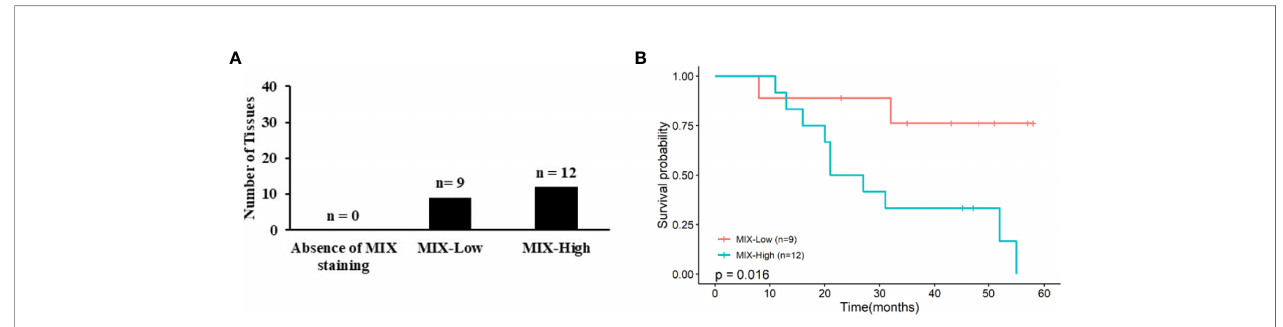
FIGURE 5 | Association between MIX scoring with chemotherapeutic-treated patients ’ survival rates at 5-years. (A) Graph represent numbers (N) of tumor samples from treated patients for which there is an absence of MIX, a MIX-Low or a MIX-High staining. All samples included (N=21) were stained with the MIX. (B) Corresponding Kaplan-Meier curves are displayed according to MIX staining (i.e., Mix-Low and -High). P values correspond to log-rank test.